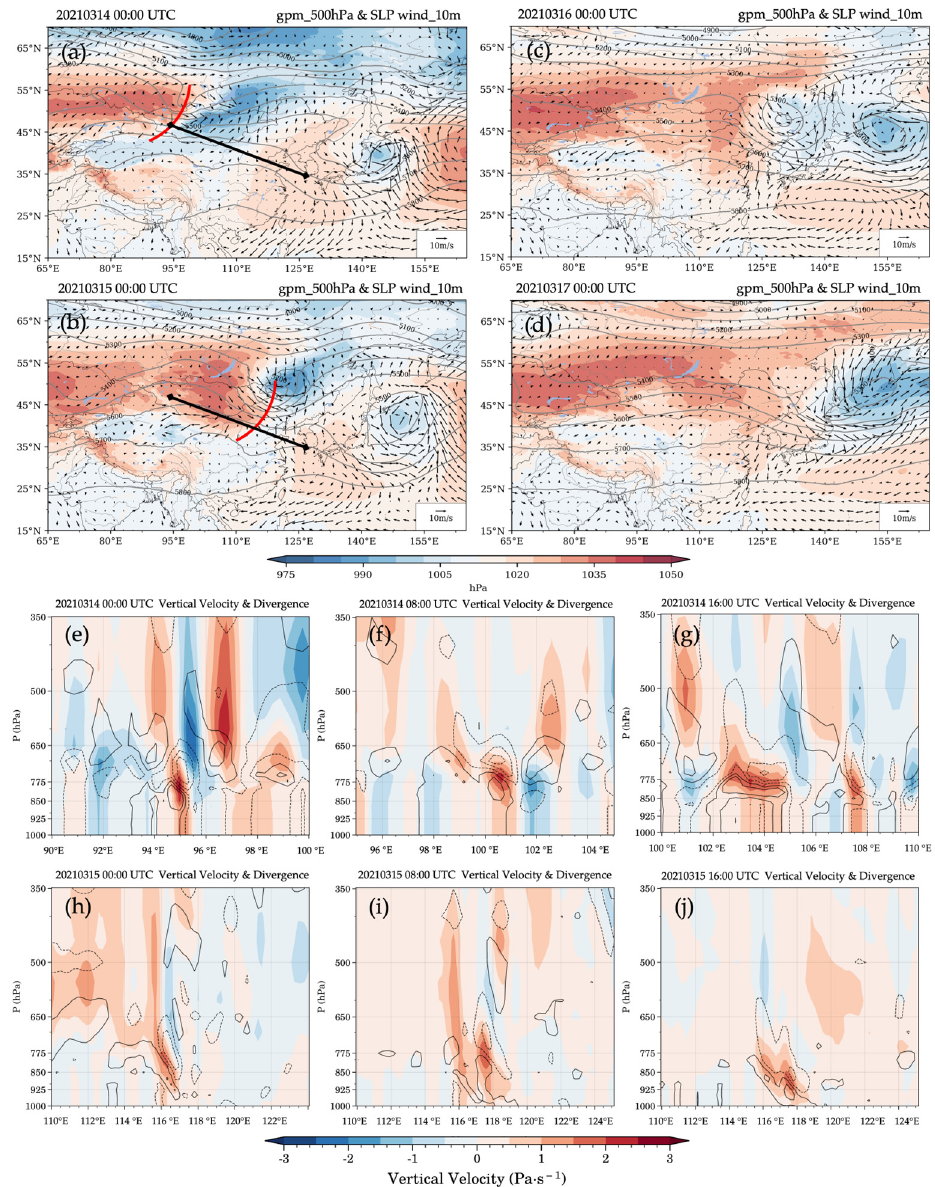
Figure 7. ( a – d ) The sea level pressure (shading) overlapped by 500 hPa geopotential height contours (gray contours) and 10-m horizontal wind vectors (arrow) at ( a ) 00:00 UTC on 14 March 2021; ( b ) 00:00 on 15 March 2021; ( c ) 00:00 on 16 March 2021; and ( d ) 00:00 on 17 March 2021. ( e – j ) The cross-sections of vertical velocity (shading) and the divergence (black contours) along the dust path (dark line in panel ( a )), including at ( e ) 00:00UTC on 14 March 2021; ( f ) 08:00 on 14 March 2021; ( g ) 16:00 on 14 March 2021; ( h ) 00:00 on 15 March 2021; ( i ) 08:00 on 15 March 2021; and ( j ) 16:00 on 15 March 2021, for the 3·15 event.